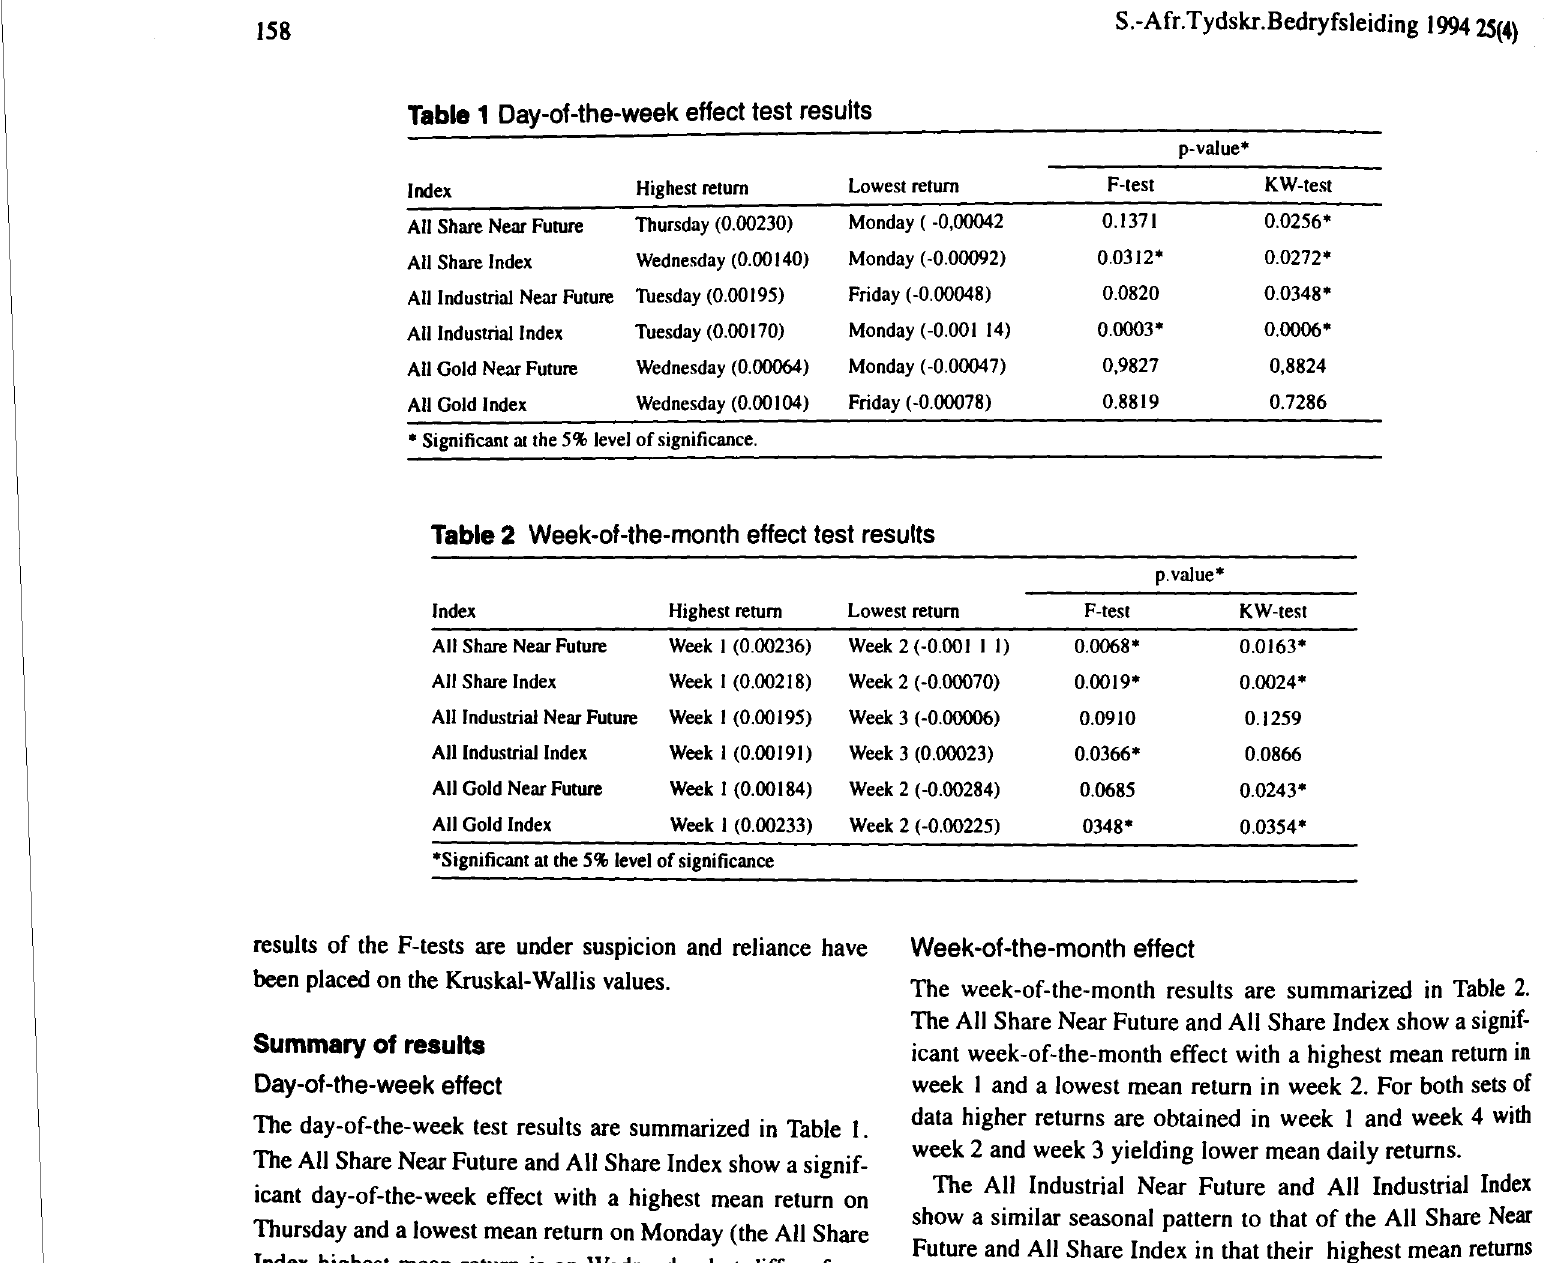
Table 1 Day-of-the-week effect test results